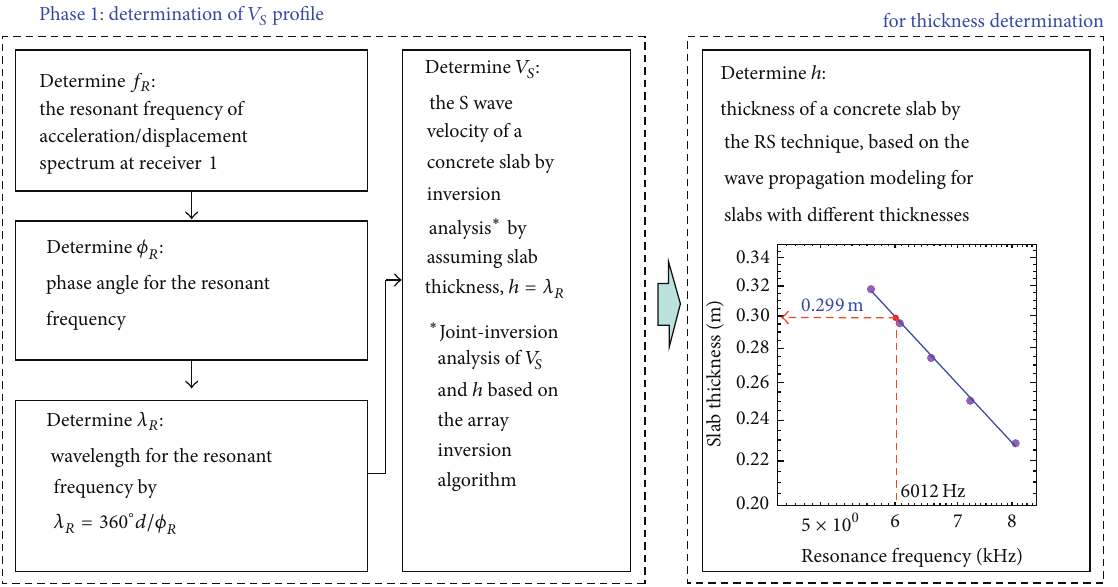
Figure 4: ERS method procedure (Cho et al., 2007 [6]).